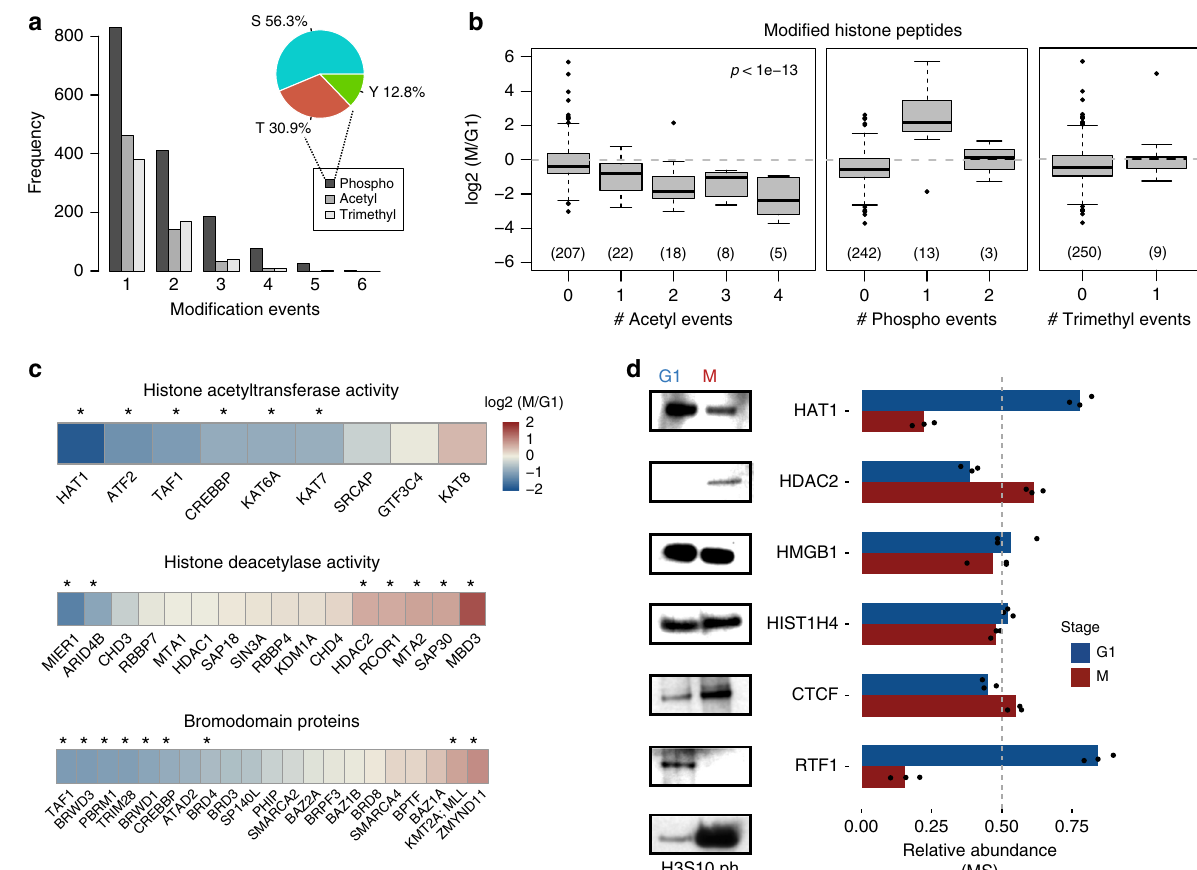
Fig. 3 Differential abundance of post-translational modi fi cations at the G1/M transition. a Frequency of peptides detected and quanti fi ed with given modi fi cations. Pie-chart inset: percentage of S, T, and Y residues at class I phosphorylation sites (localization probability ≥ 0.7). b Changes in chromatome signal for all modi fi ed histone peptides between G1 and mitosis. Boxplots represent peptides either acetylated at lysine residues (left), phosphorylated at S, T, or Y residues (middle) or trimethylated at lysine residues (right). The box represents the middle 50% of the data, the line inside the box represents the median, and whiskers are de fi ned by the most extreme values lying within 1.5 times the interquartile range. Outliers are shown as points. Numbers below boxes represent the number of peptides at each modi fi cation level. The p- value for slope of the fi t of log2(M/G1) changes regressed against the number of modi fi cations is noted in the upper right corner for acetylated peptides (see Methods). c Changes in signal for protein groups involved in writing (top), erasing (middle) and reading (bottom) histone acetylation. Asterisks above each heatmap cell represent changes that are signi fi cant ( p < 0.001, see Methods for signi fi cance determination). d Western blot of G1 and M chromatin fractions (left) with corresponding signal from triplicate MS measurements